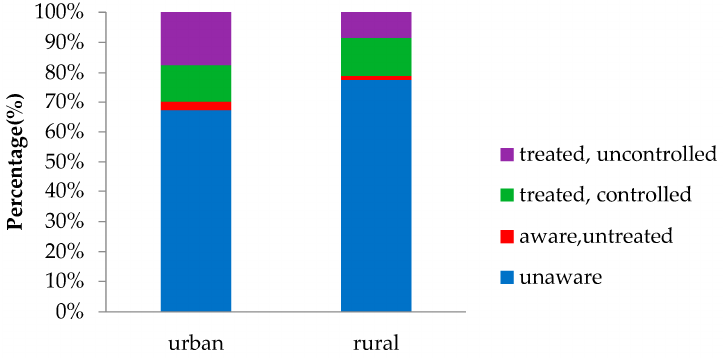
Figure 3. Rates of Awareness, Treatment, and Control of diabetes mellitus in urban and rural areas.